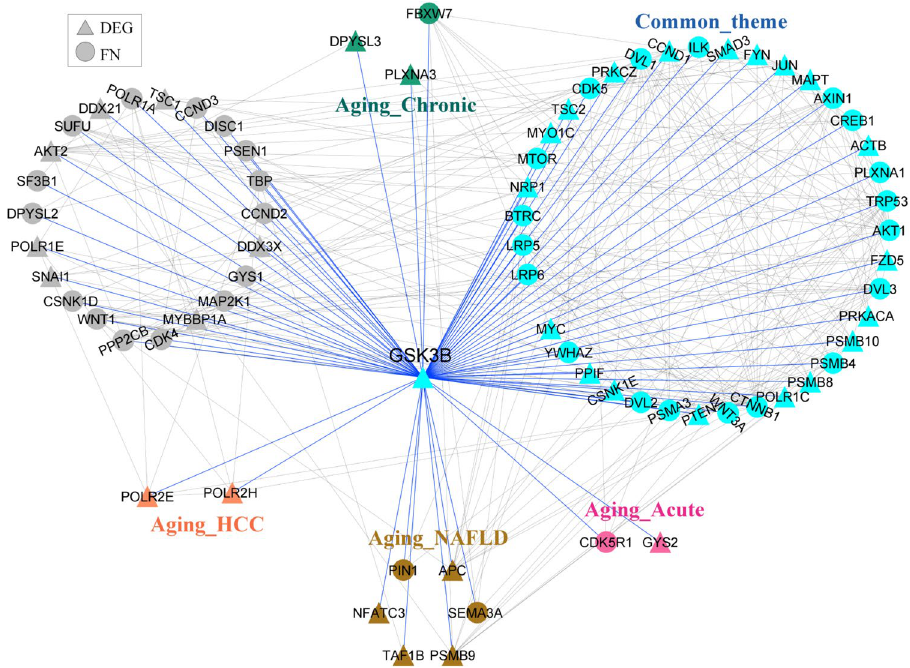
Figure 7. Interacting partners of candidate gene, GSK3β, present in the common theme.